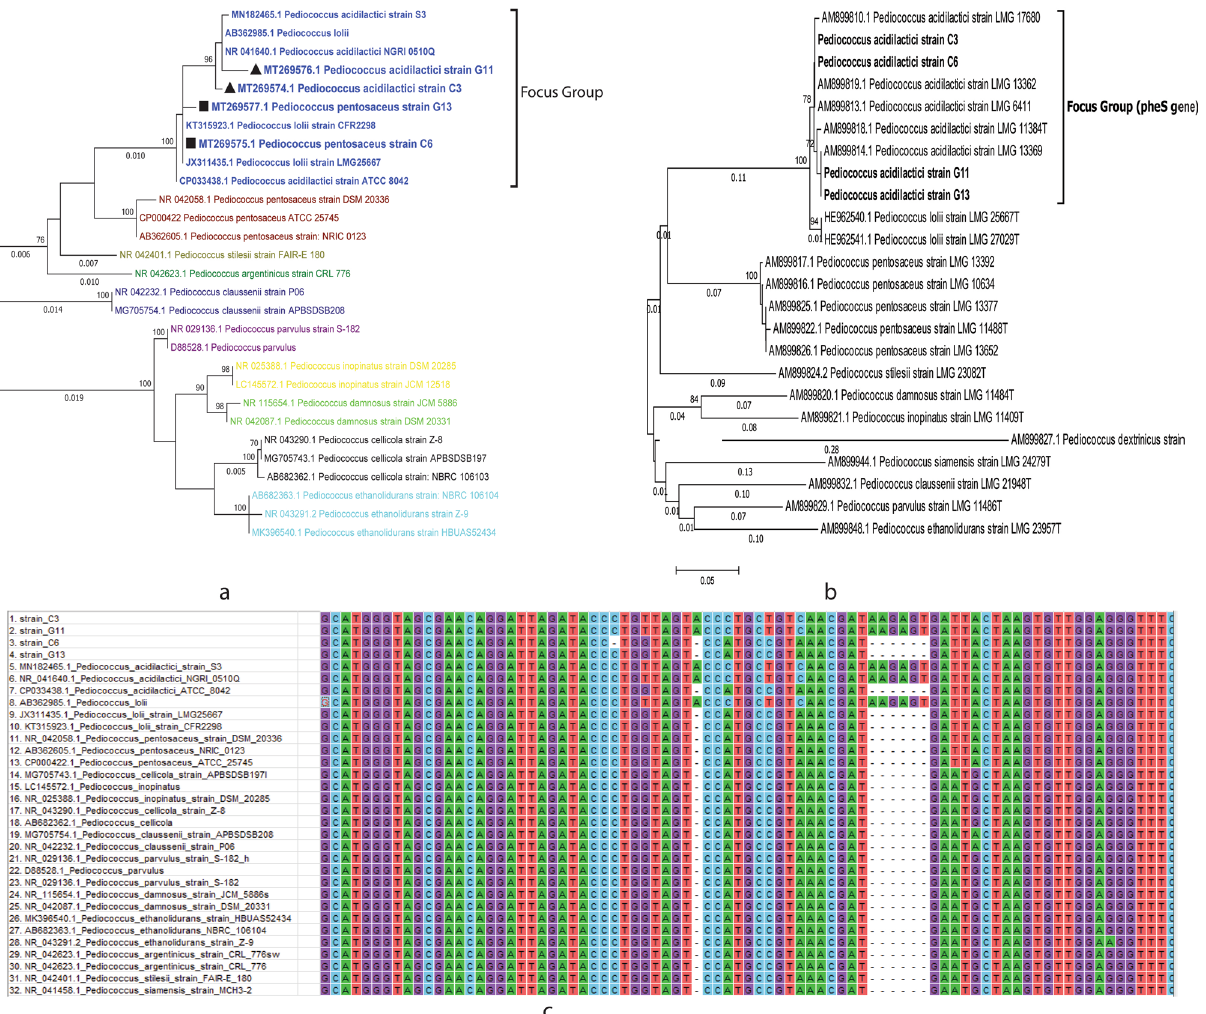
Figure 1. ( a ) 16S rDNA gene sequence based maximum likelihood tree represents the key grouping between P. acidilactici and P. pentosaceaus strains . However, due to very low diversity the phylogenetic tree could not differentiate between the P. acidilactici and P. lolii . ( b ) A phe S gene can differentiate between the P. acidilactici and P. lolii strains as shown in the focus group, and ( c ) The 6-bp deletion are found in the C6 and G13 strains that is not common in P. acidilactici . In both phylogenetics analyses ( a,b ), 1000 bootstraps were used and the trees showed > 70% values. The branch length values with more than 0.005 were shown in the